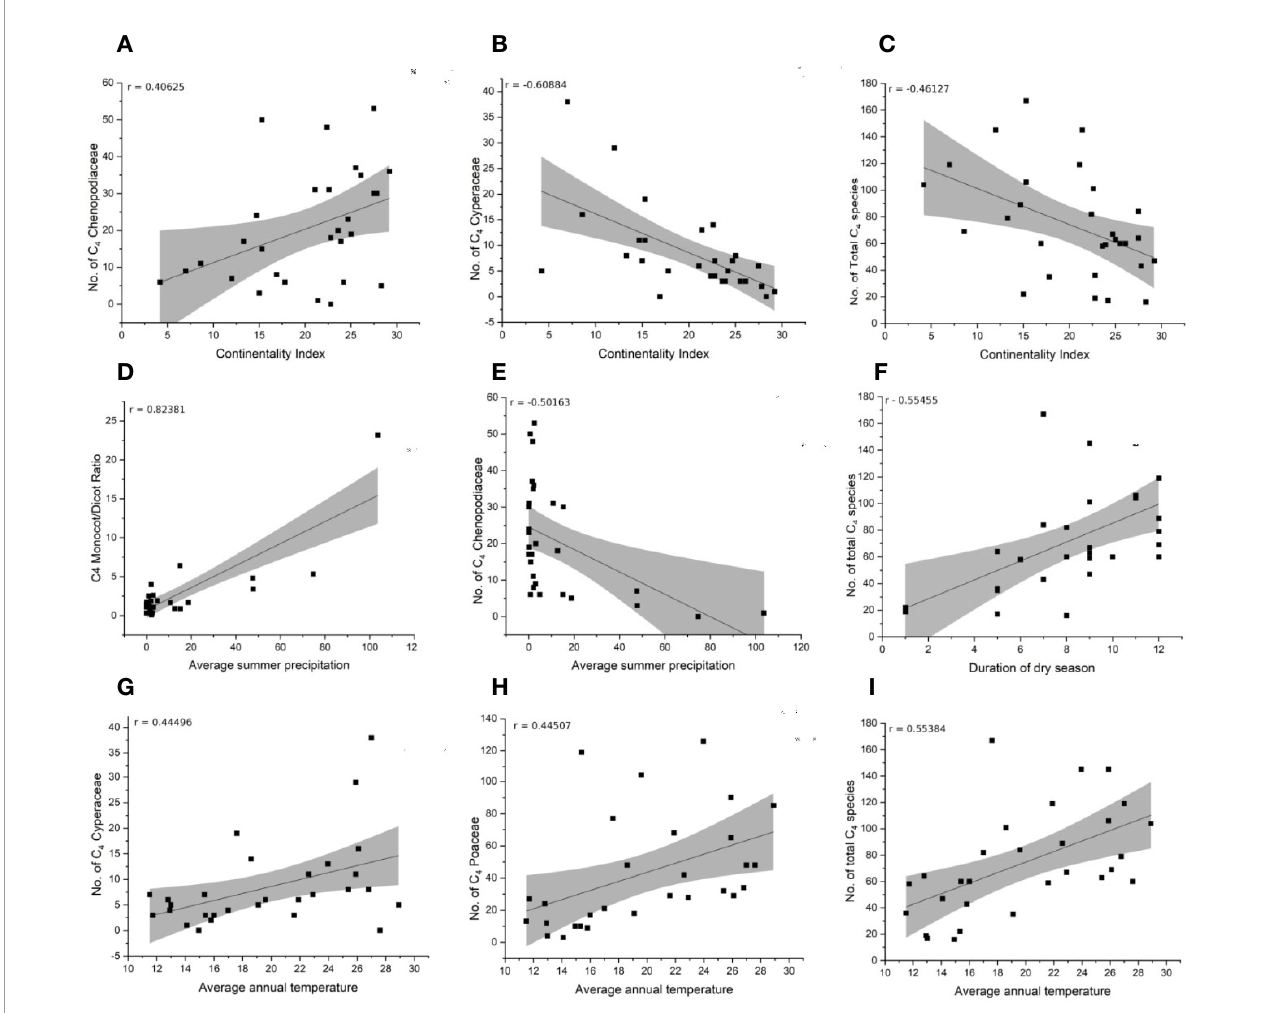
FIGURE 6 | Correlation of climate variables and distribution of C 4 main taxonomic groups (Chenopodiaceae, Cyperaceae, Poaceae, Monocot/Eudicot ratio). (A – C) Continentality index. (D, E) Average summer precipitation. (F) Duration of dry season. (G – I) Average annual